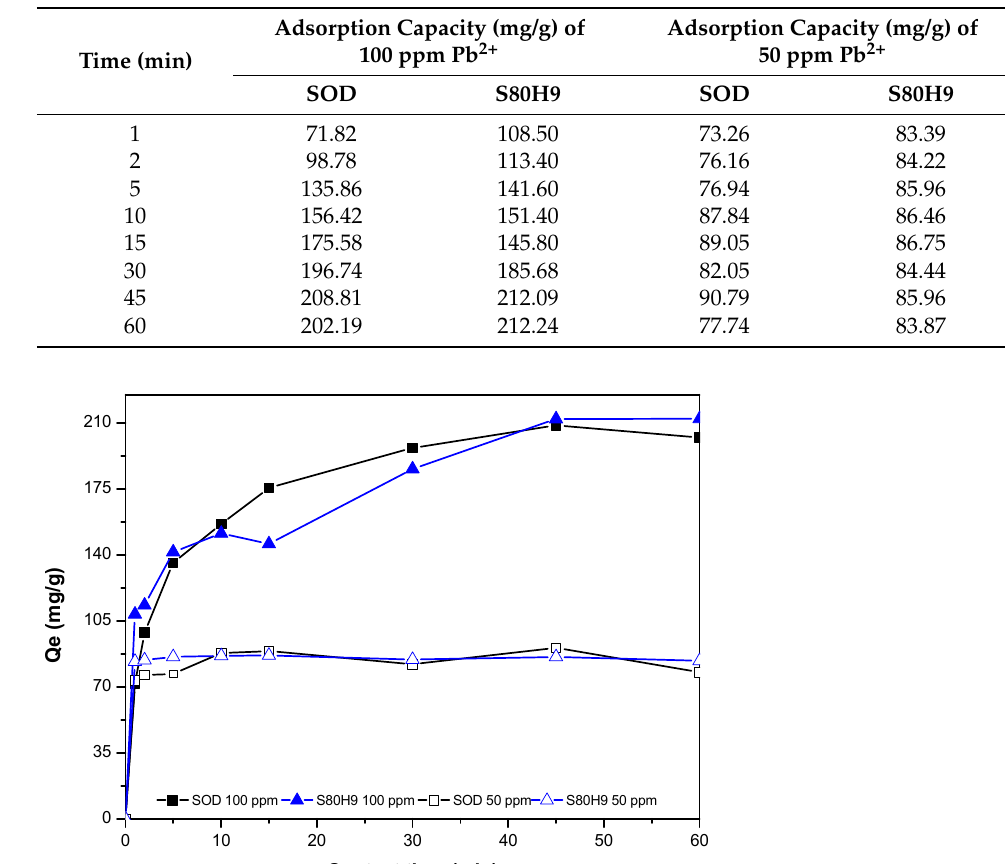
Table 6. Adsorption capacity of Pb 2+ for SOD and S80H9.